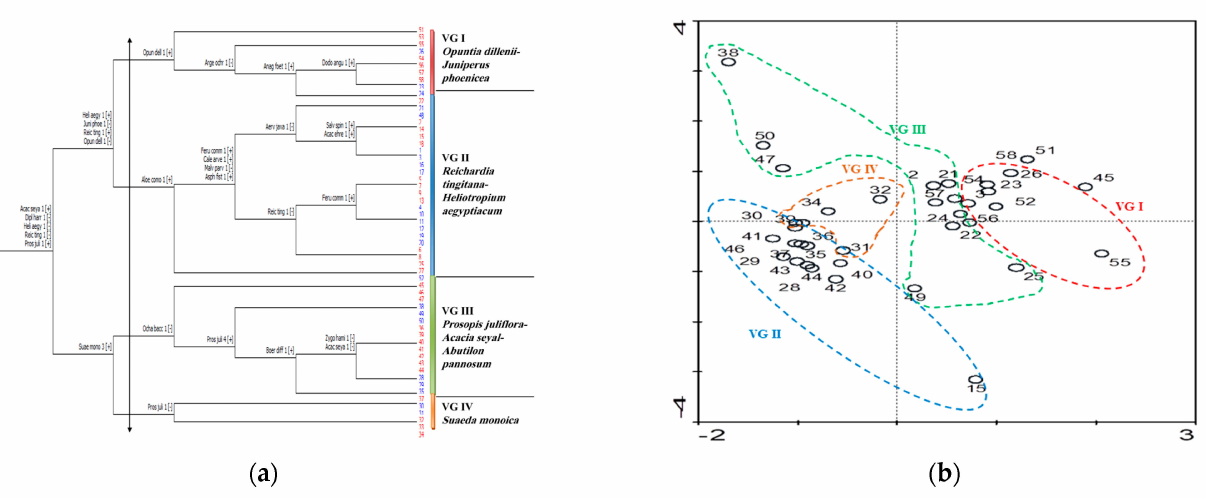
Figure 3. ( a ) Multivariate analysis of the 58 sampling stands by TWINSPAN classified them into four vegetation groups. ( b ) The stands ordination by DECORANA software confirmed the classification into four vegetation groups. The identified groups are VG I: Opuntia ficus-indica-Juniperus phoenicea , VG II: Reichardia tingitana-Heliotropium aegyptiacum , VG III: Prosopis juliflora-Acacia